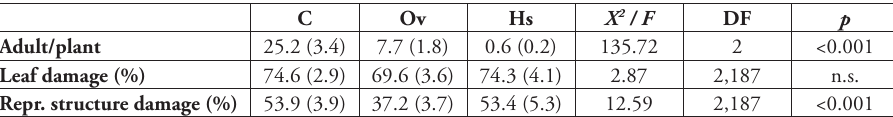
Table 1. O. communa density and damage on A. artemisiifolia . Mean values (± SE) for adult O. com- muna per plant and A. artemisiifolia damage on leaves and reproductive structures in the three treatments (C: control, Ov: over-seeded and Hs: hayseed) in September 2015, with X 2 / F tests results. C Ov Hs X 2 / F DF p